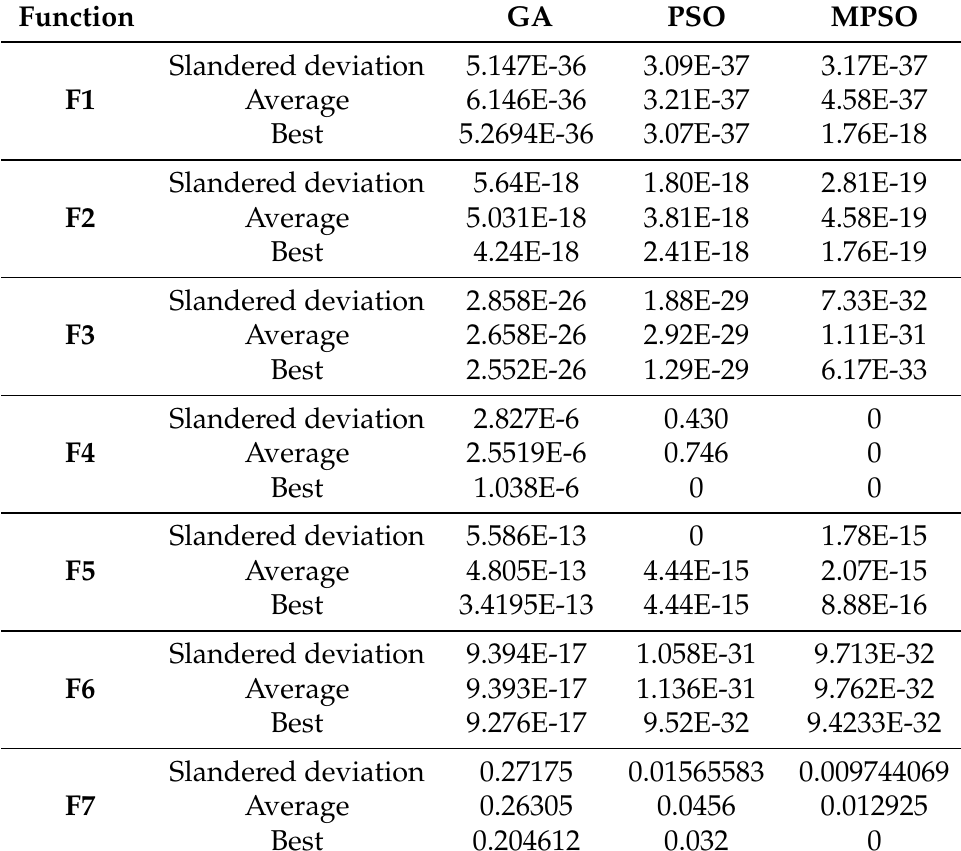
Table 2. Performance comparison between traditional optimization and MPSO